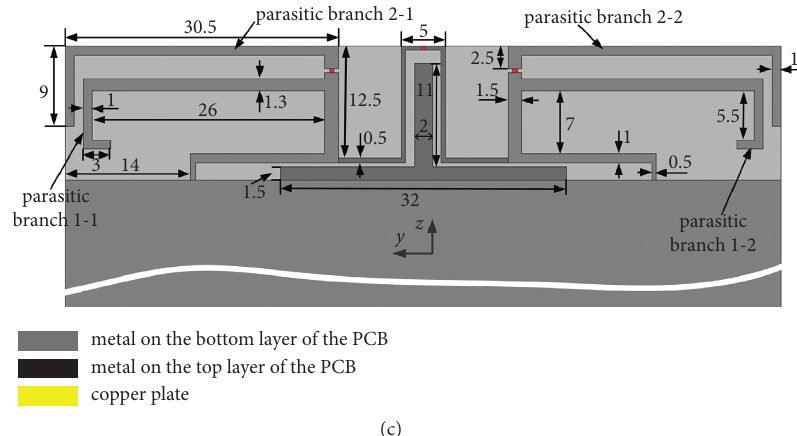
Figure 1: Antenna geometry with detailed dimensions. (a) Prospective view. (b) Front view. (c) Back view (the folded copper plate and the metal in the top layer are omitted).